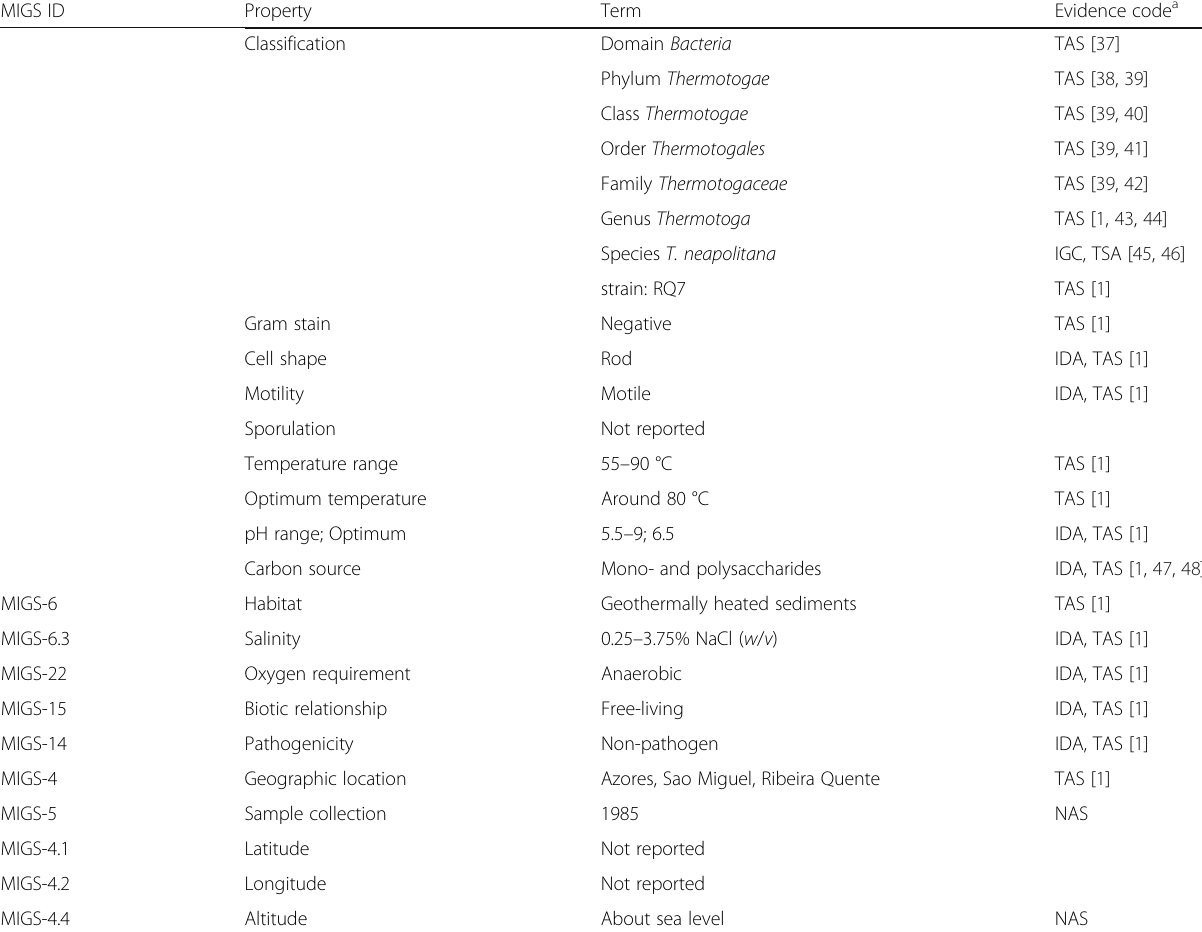
Table 1 Classification and general features of Thermotoga sp. strain RQ7 according to the MIGS recommendations [36]